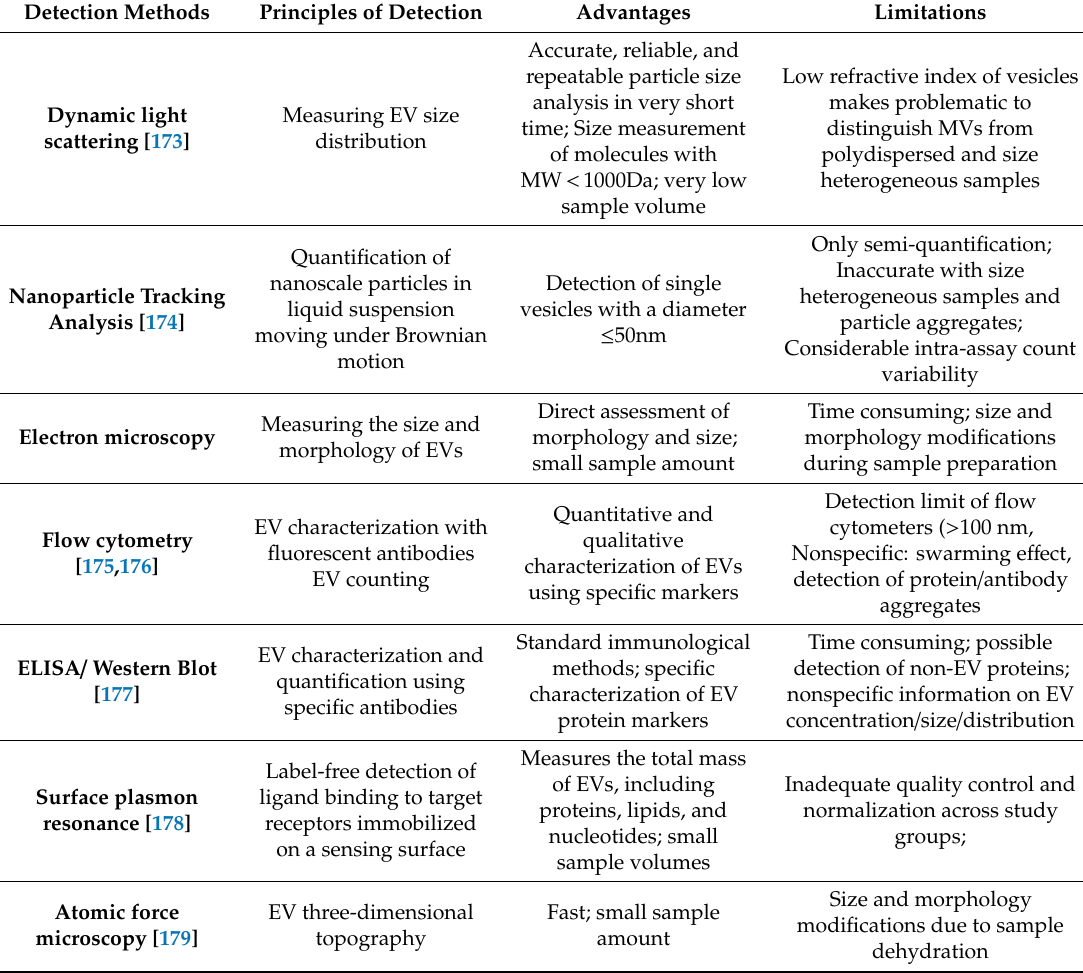
Table 2. Detection methods of EVs with their advantages and